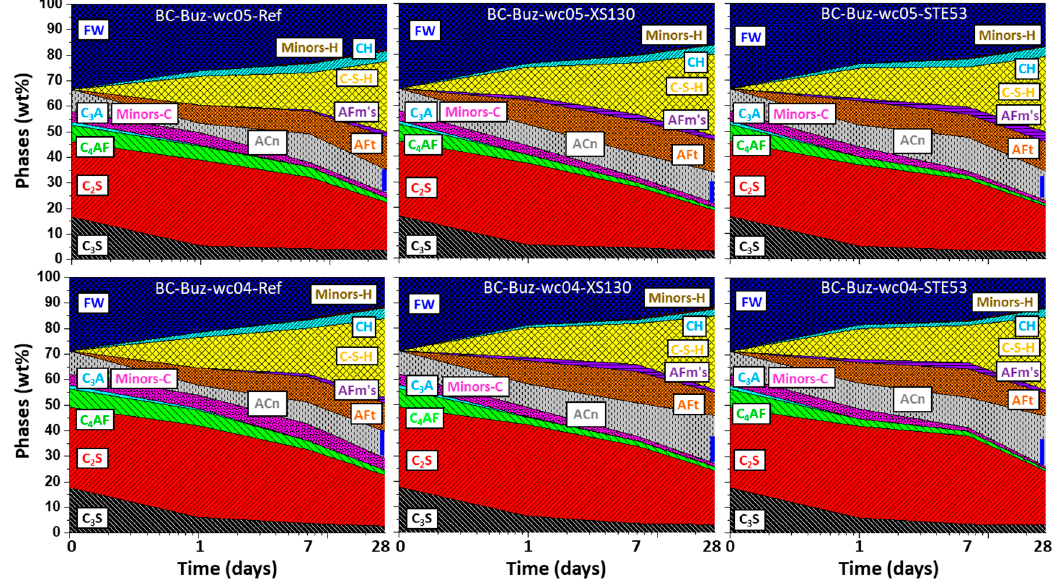
Figure 5. Phase development for BC-Buz ( top ) w / c = 0.50, ( bottom ) w / c = 0.40, with all details as in Figure 4. Minors-H stands for any minor hydrated phase not accounted for in the explicitly given ones.